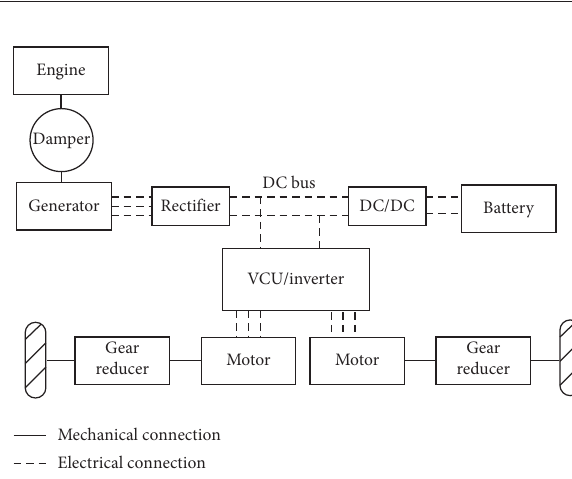
Figure 10: Configuration of the series